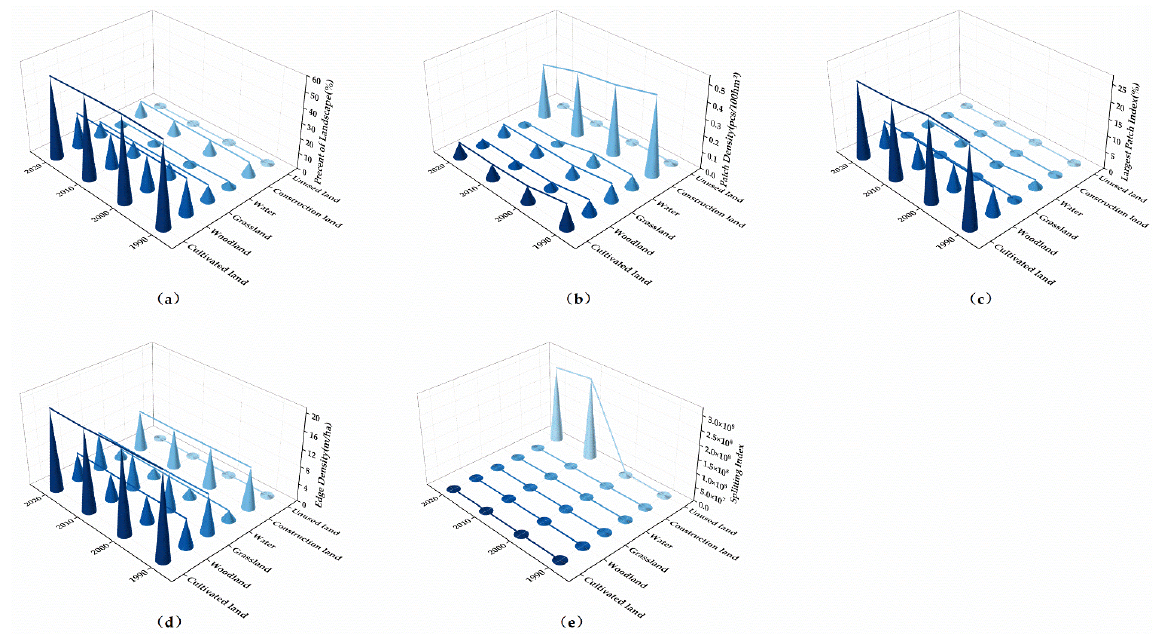
Figure 8. Changes of landscape metrics: ( a ) Percentage of Landscape (PLAND), ( b ) Patch density (PD), ( c ) Largest Patch Index (LPI), ( d ) Edge density (ED), and ( e ) Splitting Index (SPLIT) at the patch type level from 1990 to 2020.